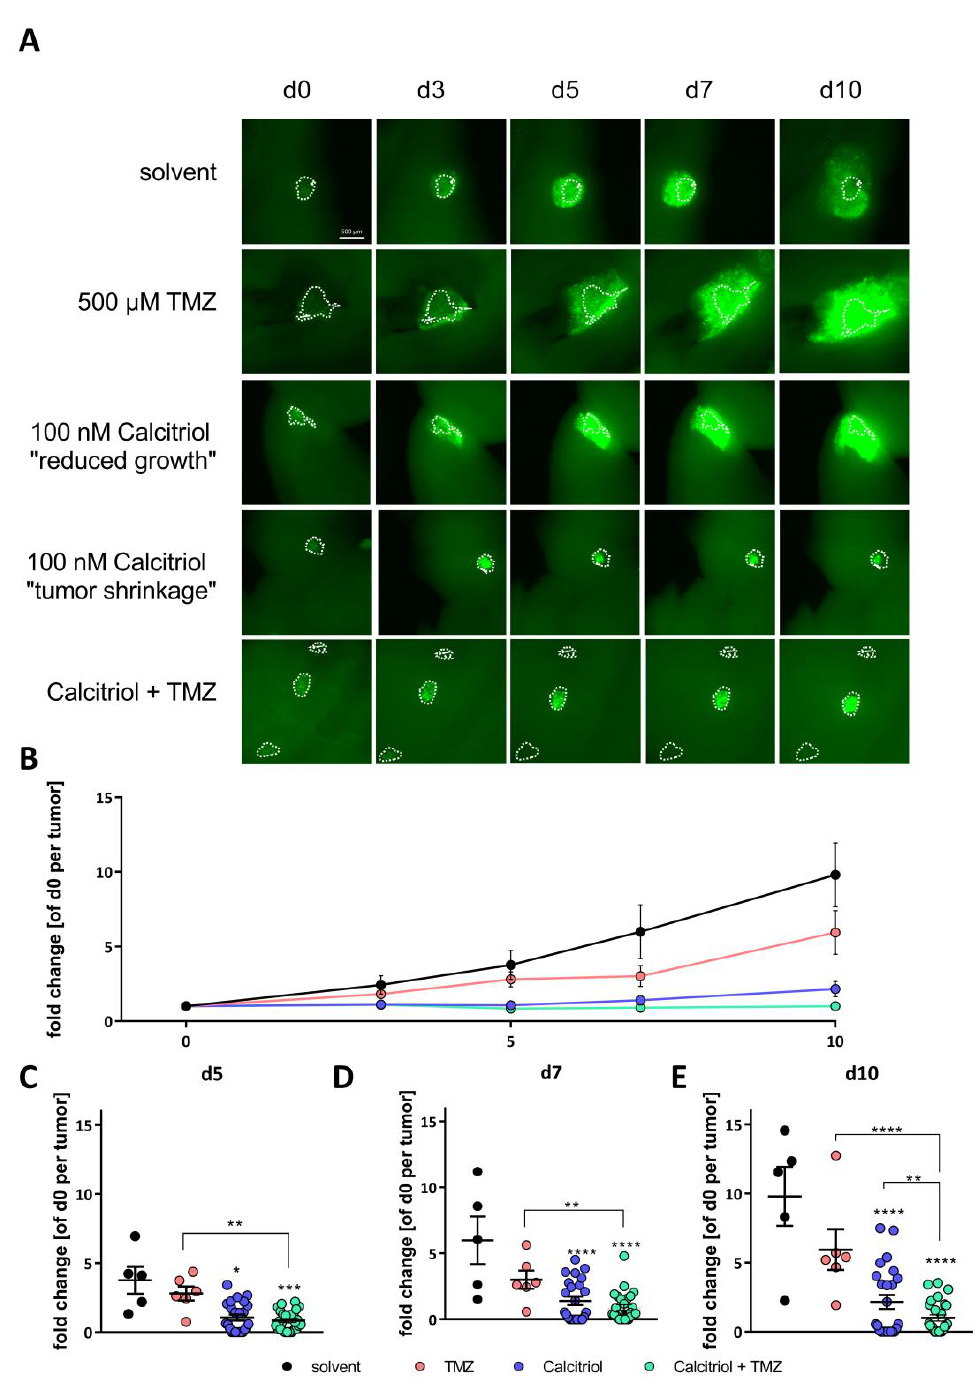
Figure 8. Calcitriol halts tumor growth and synergizes with TMZ in ex vivo organotypic tissue culture tumor growth kinetics: ( A ) representative microphotographs of NCH644 GFP + tumors transplanted onto adult murine brain organotypic tissue culture slices after treatment with solvent (DMSO for TMZ; EtOH for calcitriol), 500 µM of TMZ, 100 nM of calcitriol (Cal) or a combination of both for the times indicated; scale bar: 500 µm. ( B ) Growth curves of the NCH644 GFP + tumors normalized to the size of tumor d0 after treatment as in ( A ) depicted as the mean +/- SEM. ( C – E ) Point-plot of the data summarized in ( B ) after treatment for ( C ) 5 days, ( D ), 7 days and ( E ) 10 days, as in ( A ). * p < 0.05; ** p < 0.01; *** p < 0.001; **** p < 0.0001; two-way ANOVA with Tukey’s multiple comparisons test.